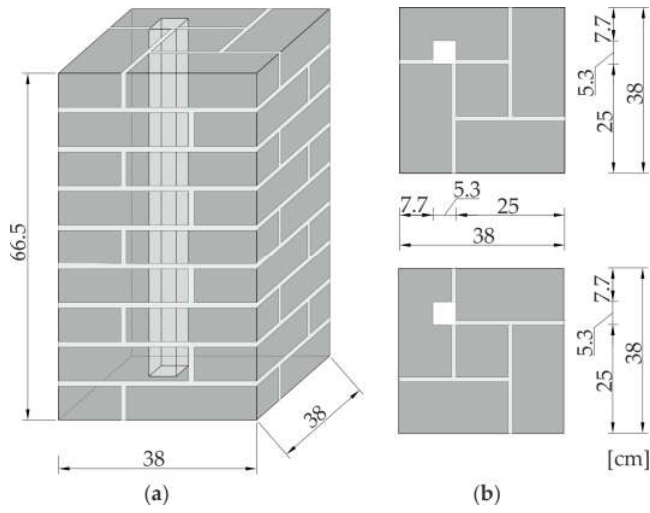
Figure 2. Geometry of the tested pillars: ( a ) 3D view; ( b ) plane view of even and odd layers.